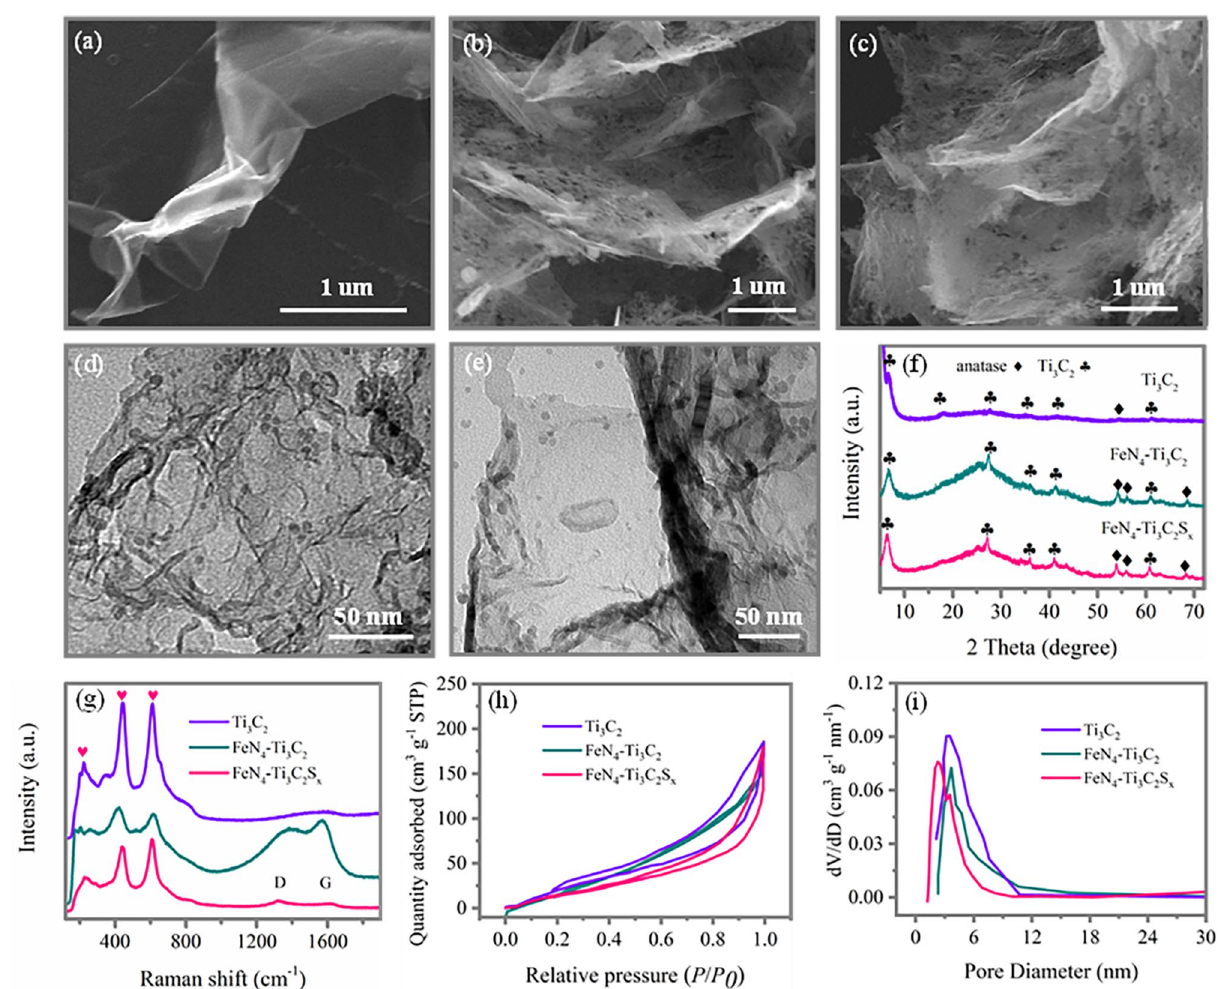
Fig. 1 SEM images for a pristine Ti 3 C 2 , b FeN 4 –Ti 3 C 2 , and c FeN 4 –Ti 3 C 2 S x . TEM images for d FeN 4 –Ti 3 C 2 , and e FeN 4 –Ti 3 C 2 S x . f XRD pat- terns, and g Raman spectra. h